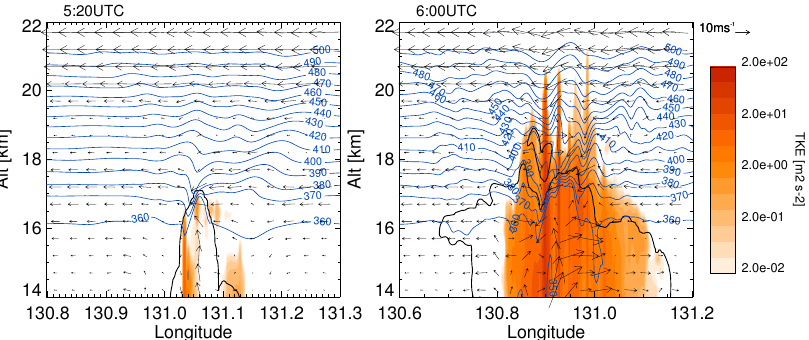
Figure 12. Vertical cross sections of parameterised TKE at 05:20UTC (left) and 06:00UTC (right). The thick black line denotes the 0.01gkg − 1 ice mixing ratio and the thinner blue lines depict isentropes. Also superimposed are the u − w wind